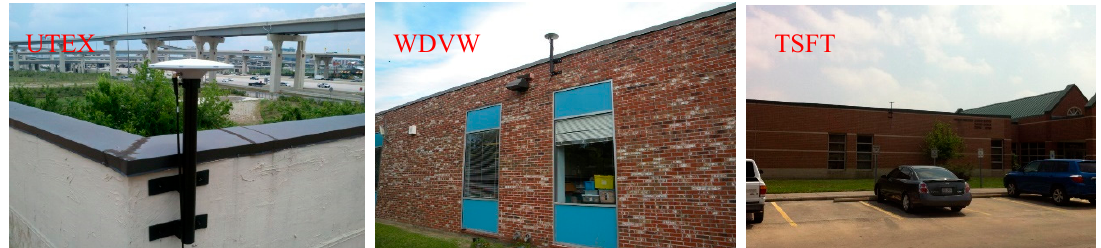
Figure 6. Photos showing typical field installations of the Long Point Fault GPS antennas.